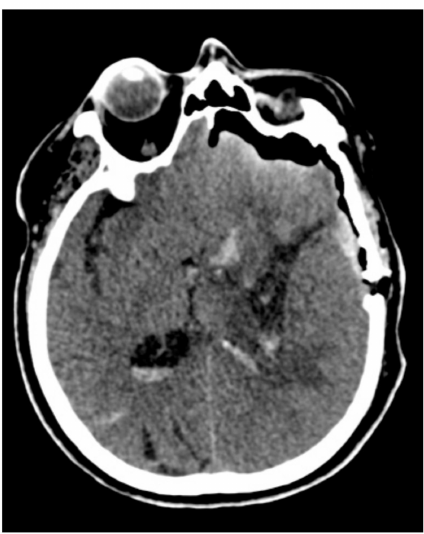
Figure 4. Control computed tomography (CT) after the microscopic minimally invasive subtotal evacuation of the